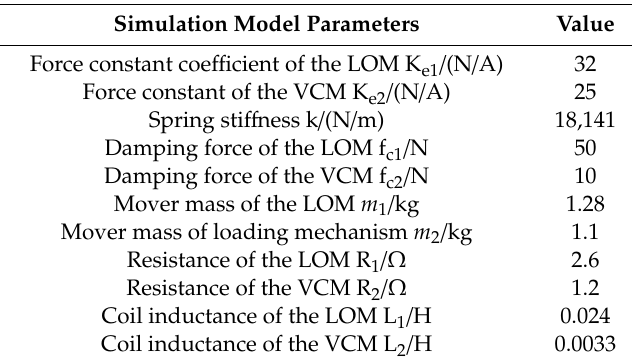
Table 1. Main parameters of the LOLS.